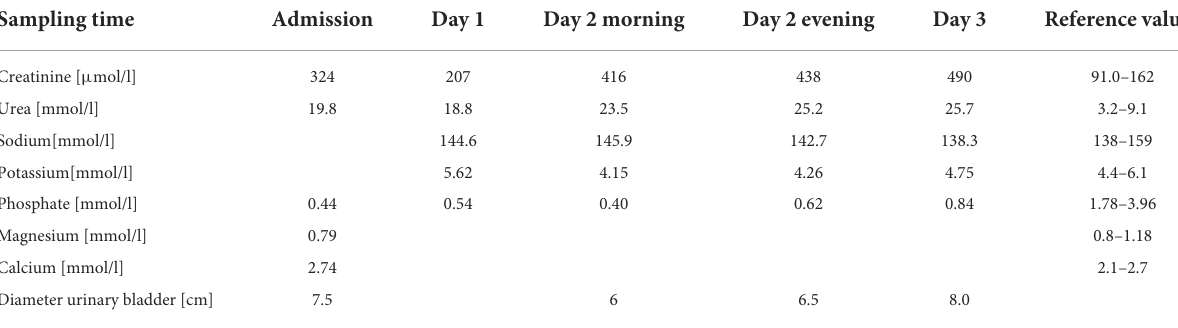
TABLE 1 Concentration of various plasma parameters and urinary bladder diameter during the clinic